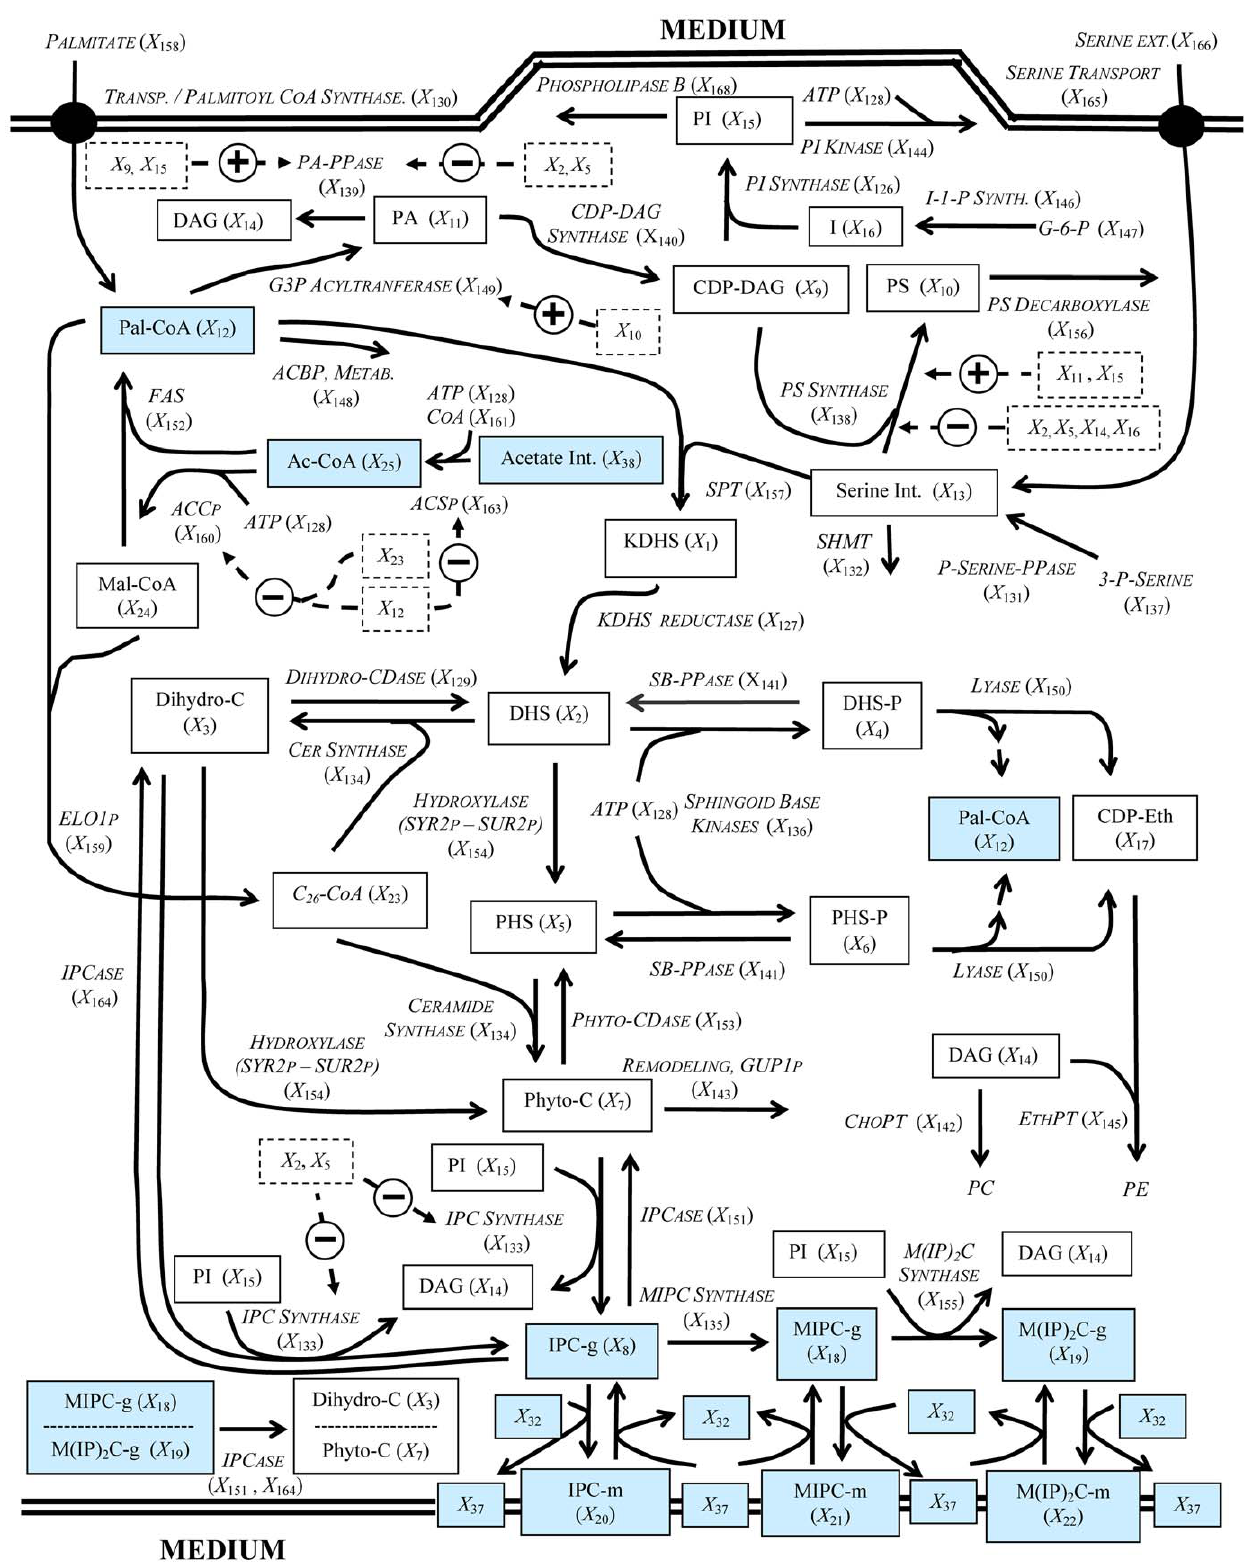
Figure 2. Sphingolipid model for yeast. Solid boxes represent time dependent variables, italics represent variables assumed to be time independent, dashed boxes represent variables with inhibitory or activating effects, dashed arrows represent more than one enzymatic reaction taking place. Blue boxes represent metabolites in common with the ergosterol pathway from Fig. 1. Abbreviations for the time dependent variables: 3-Keto-Sphinganine (KDHS), X 1 ; Sphinganine (DHS), X 2 ; Dihydroceramide (Dihydro-C), X 3 ; Sphinganine-1P (DHS-P), X 4 ; 4-OH-Sphinganine (PHS), X 5 ;